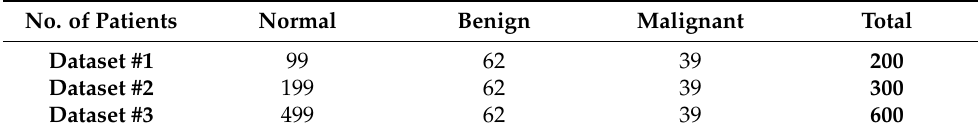
Table 3. Details of each dataset in the proposed